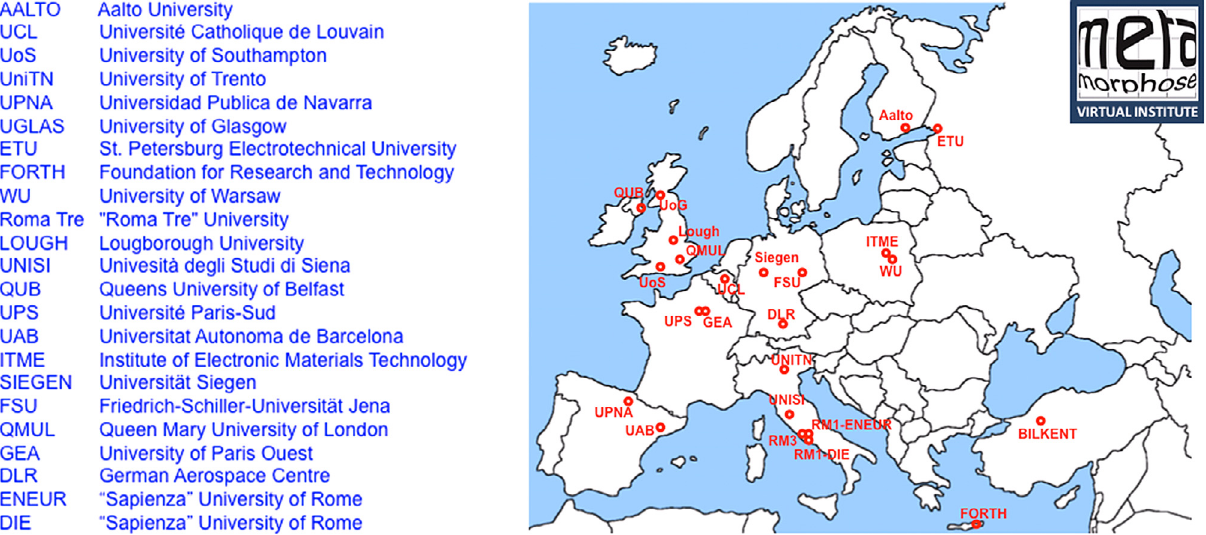
Figure 2. List and geographical distribution of the institutional members of the METAMORPHOSE VI.